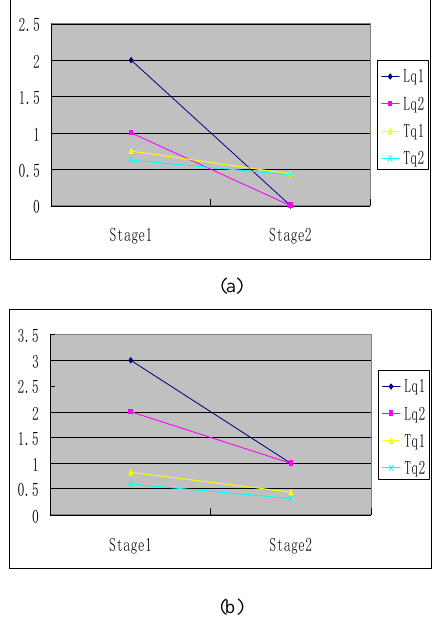
Fig.14. Contrastive results of interaction chain attributes in two